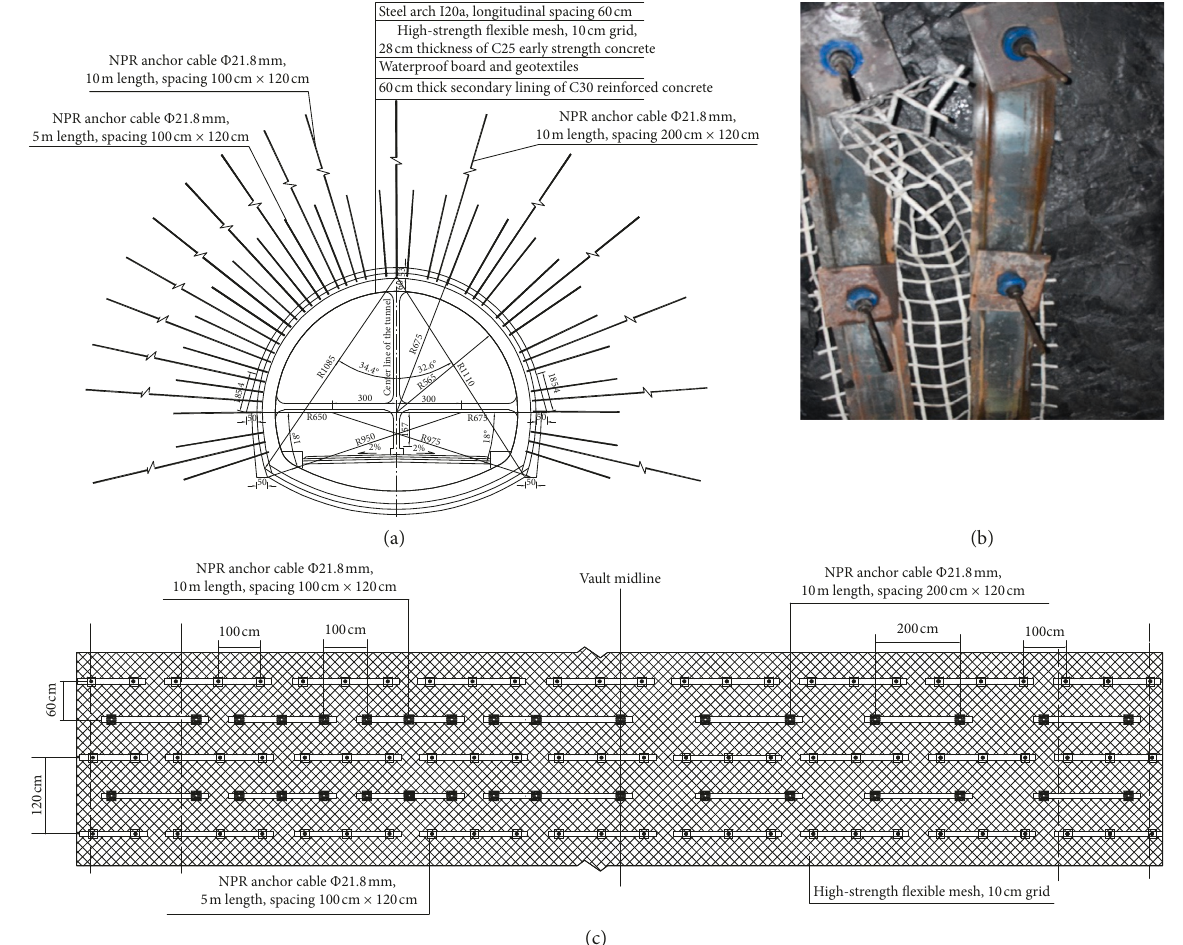
Figure 12: NPR anchor cable support in the tunnel. (a) Cross section of the tunnel supported by the NPR anchor cable. (b) Photo of the NPR anchor cable support. (c) Tunnel annular arrangement of the NPR anchor cable.